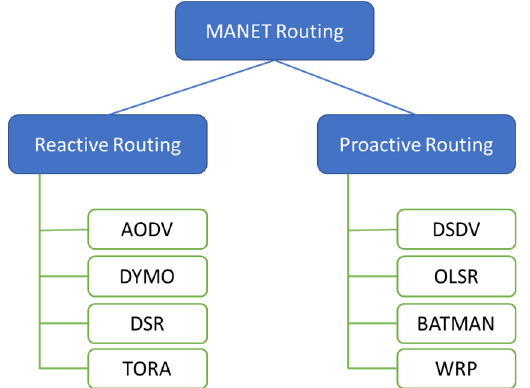
Figure 7. Taxonomy of Mobile ad hoc Network (MANET) routing protocols.